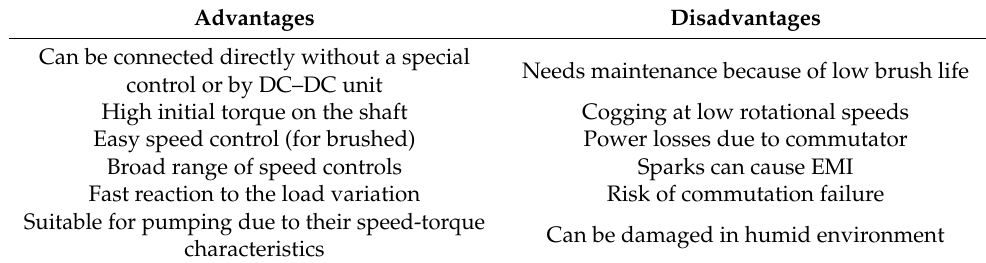
Table 3. Advantages and disadvantages of AC